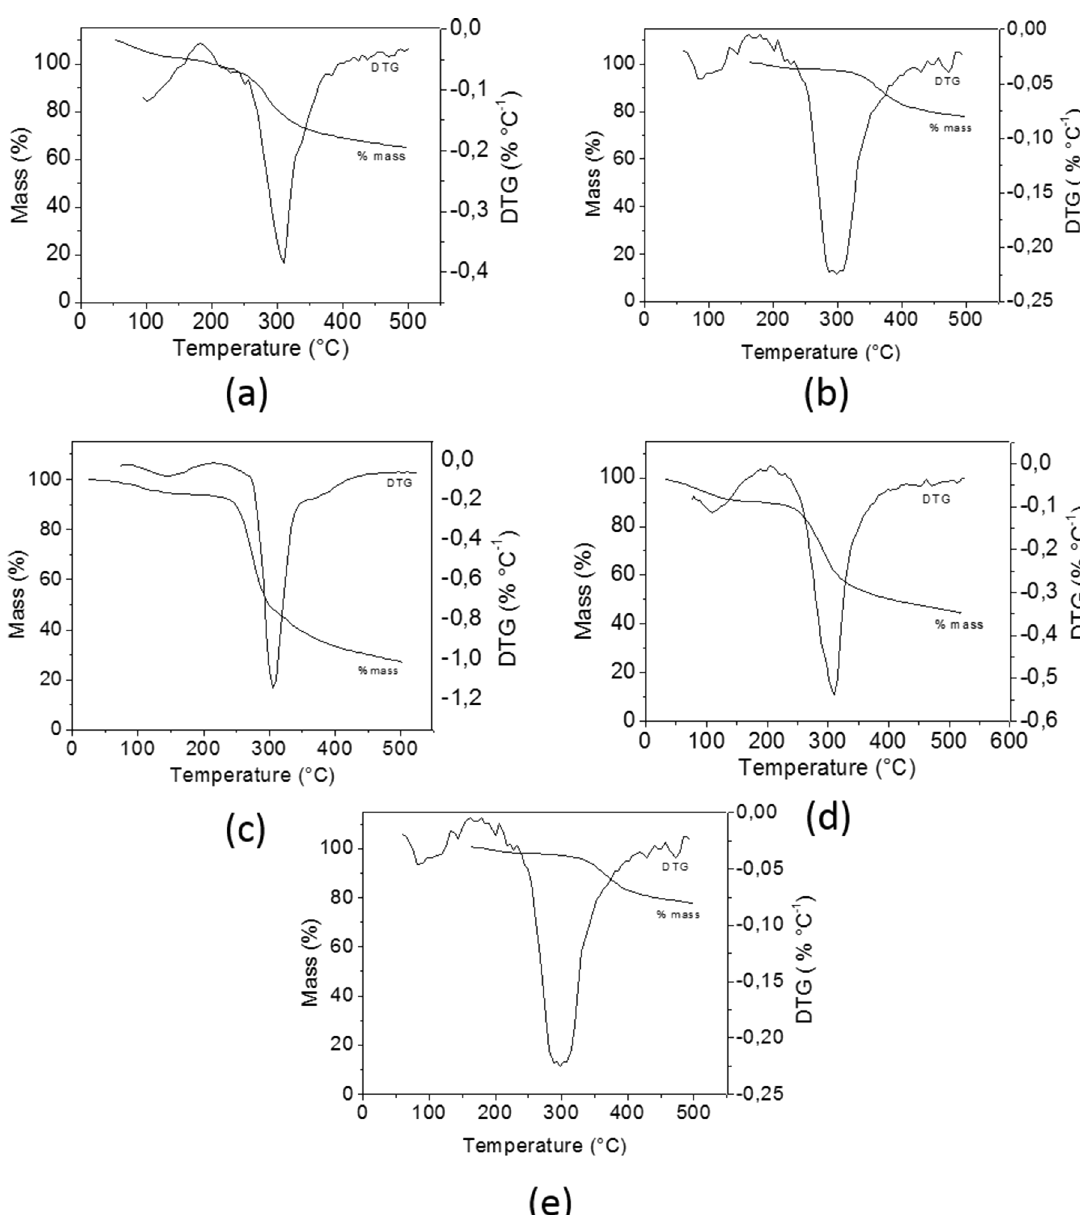
Figure 5. Termogravimetric analysis (TG) and Derivative TG curves of (a) CS-GP,(b) CS-GP-GA, (c) free lipase(d) lipase immobilized by physical adsorption (PA), and (e) lipase immobilized by covalent attachment (CA).